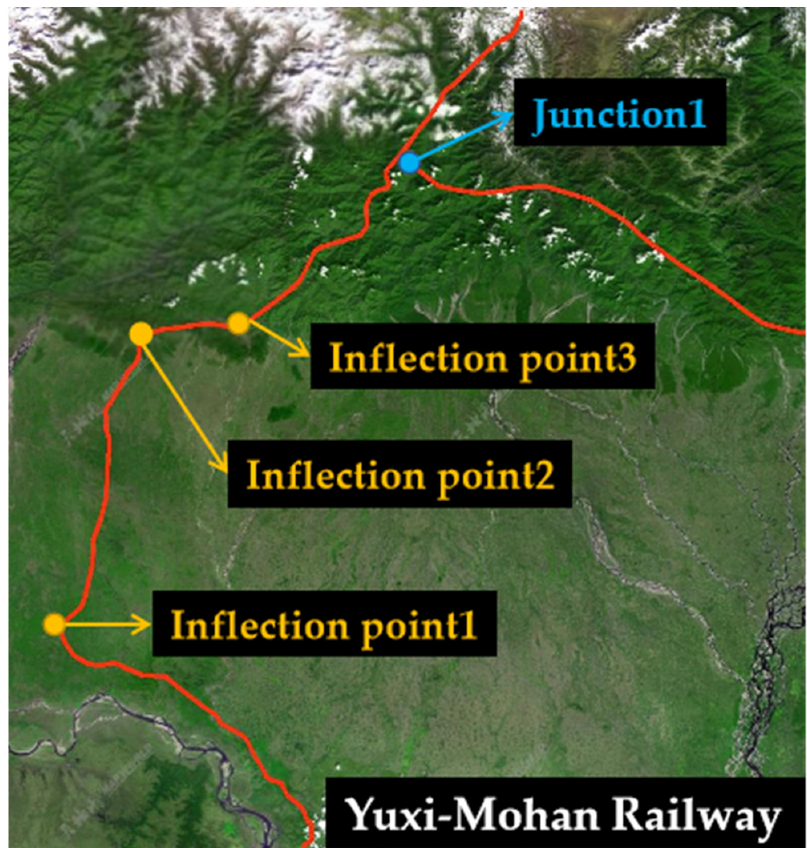
Figure 6. Range of experimental data. It contains a junction and three corners in two roads.